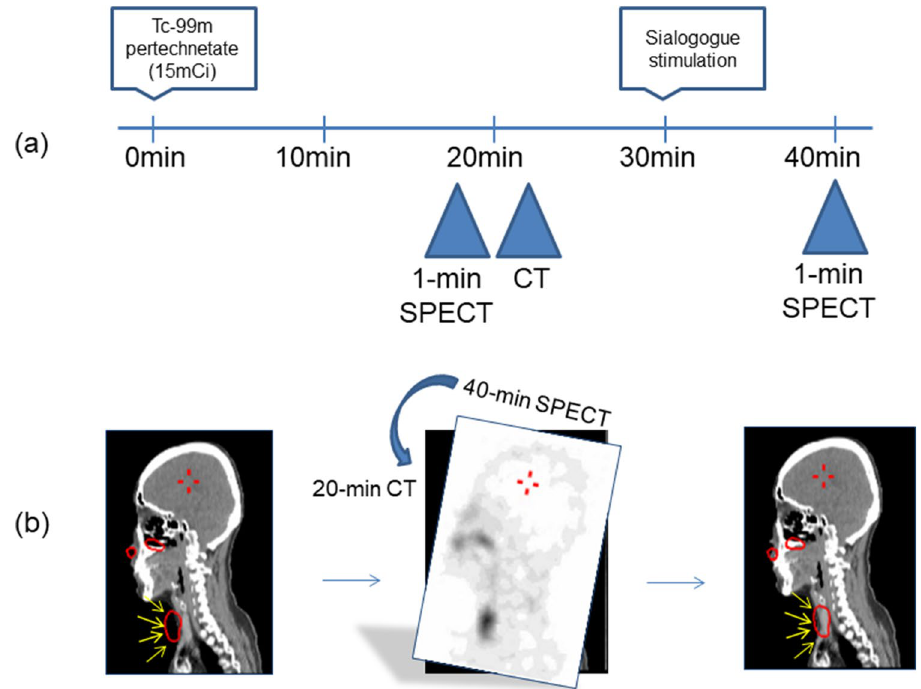
Figure 1. ( a ) Proposed salivary gland SPECT/CT protocol. ( b ) A 20-min CT was employed to reconstruct the 40-min SPECT; misregistration between the CT and SPECT was corrected using vendor-provided quality control functions (Hybrid QC, Preparation for Q.Metrix, GE). The misregistration correction process is three-dimensional in nature, but only sagittal plane images are presented for convenience. Please note that misregistered thyroid activity (the large ROI in red) is correctly adjusted to the genuine thyroid tissue after the quality control process (yellow